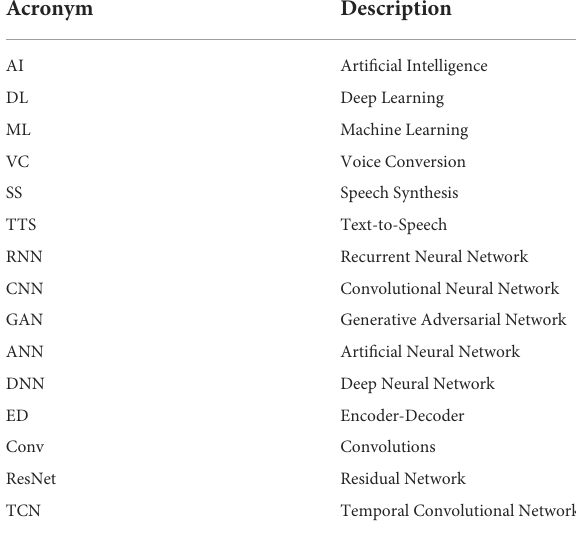
TABLE 1 The acronyms used in this